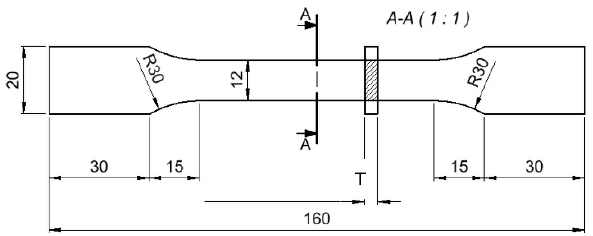
Figure 1. Sample for uniaxial tensile testing of selected materials (dimensions in mm).